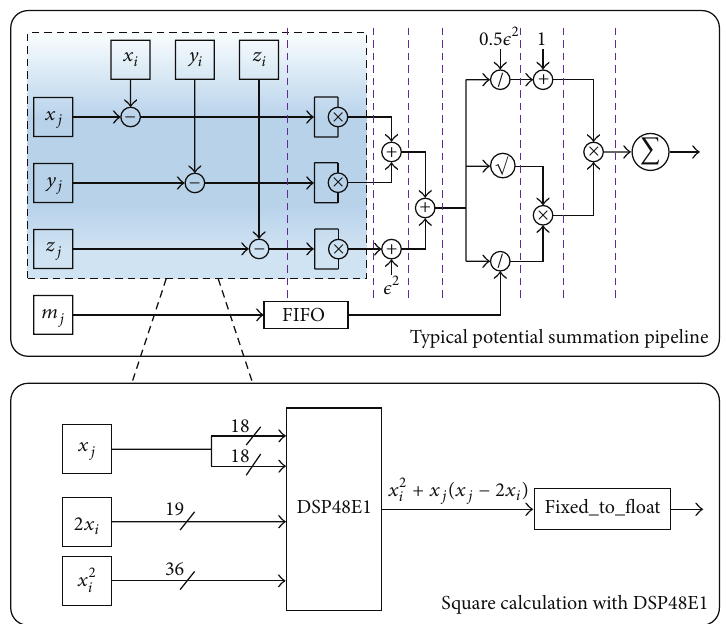
Figure 5: Up: typical potential summation pipeline with stage optimization; dotted line shows the dividing of pipeline stages. Down: modifying the logic in shadow box with